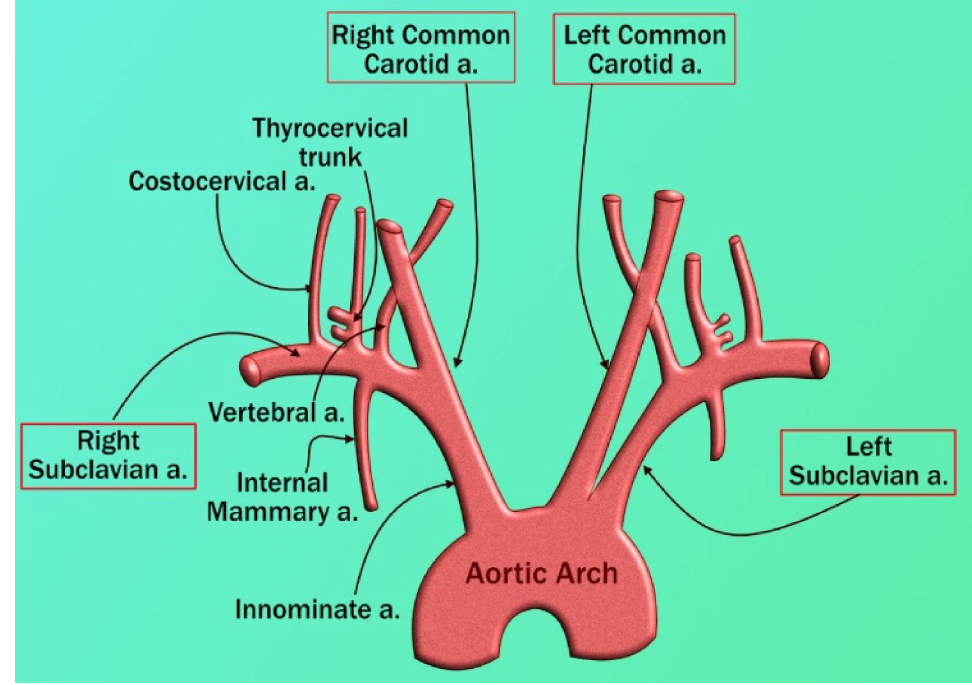
Figure 4. The inception of the left and right carotid arteries